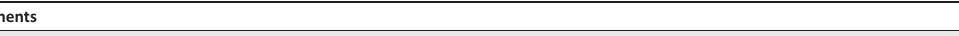
TABLE 4: Middle manager role in competitive